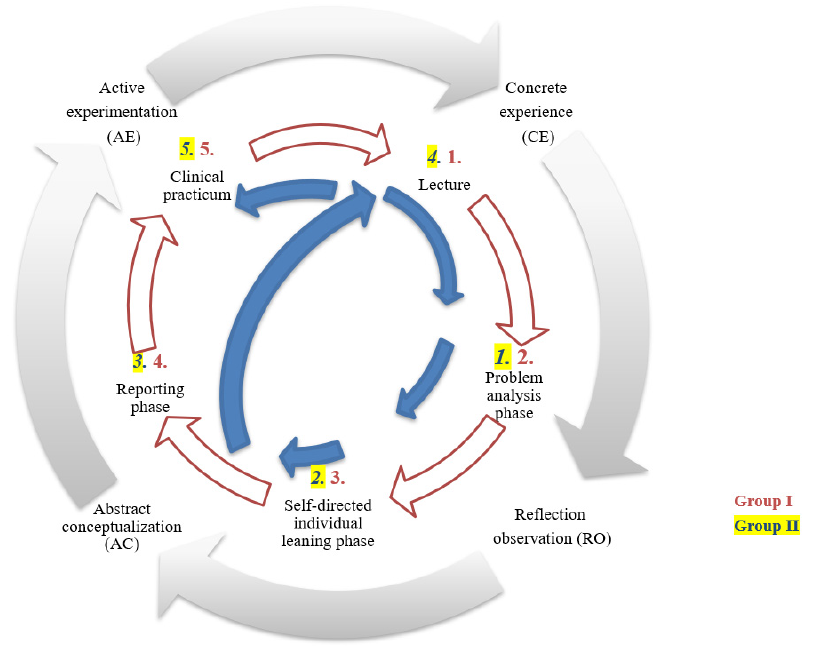
Figure 1. The different phases of problem learning, lecture-based learning, and clinical practicum in the experimental learning model between Group I and Group II.